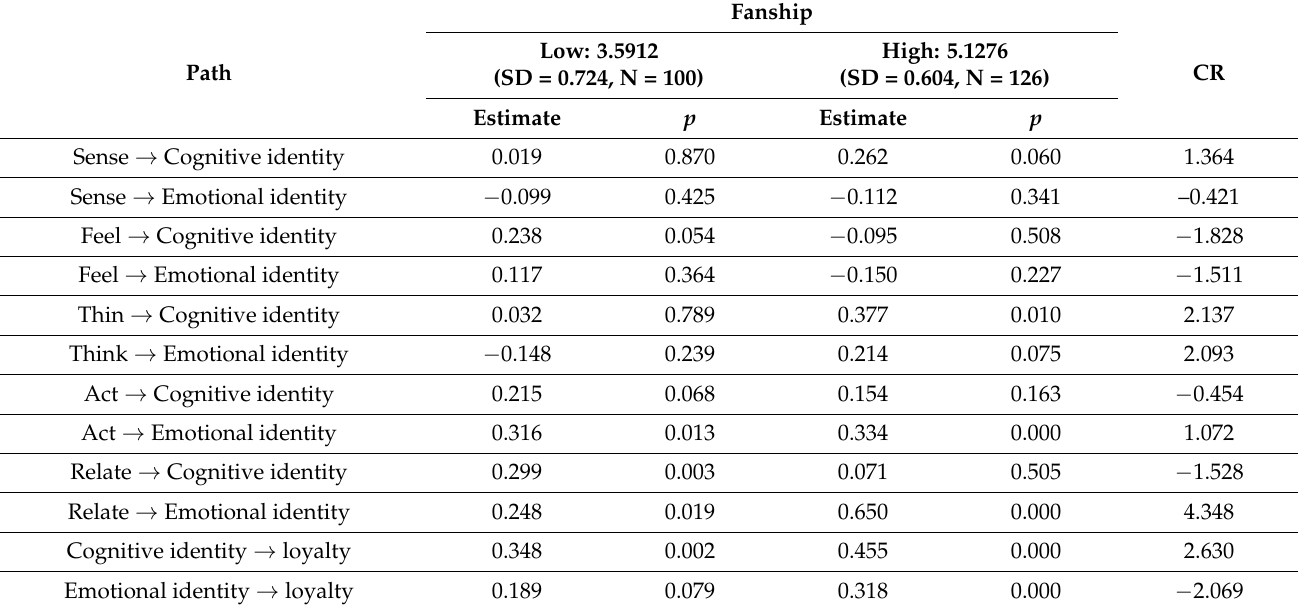
Table 5. Results of moderating